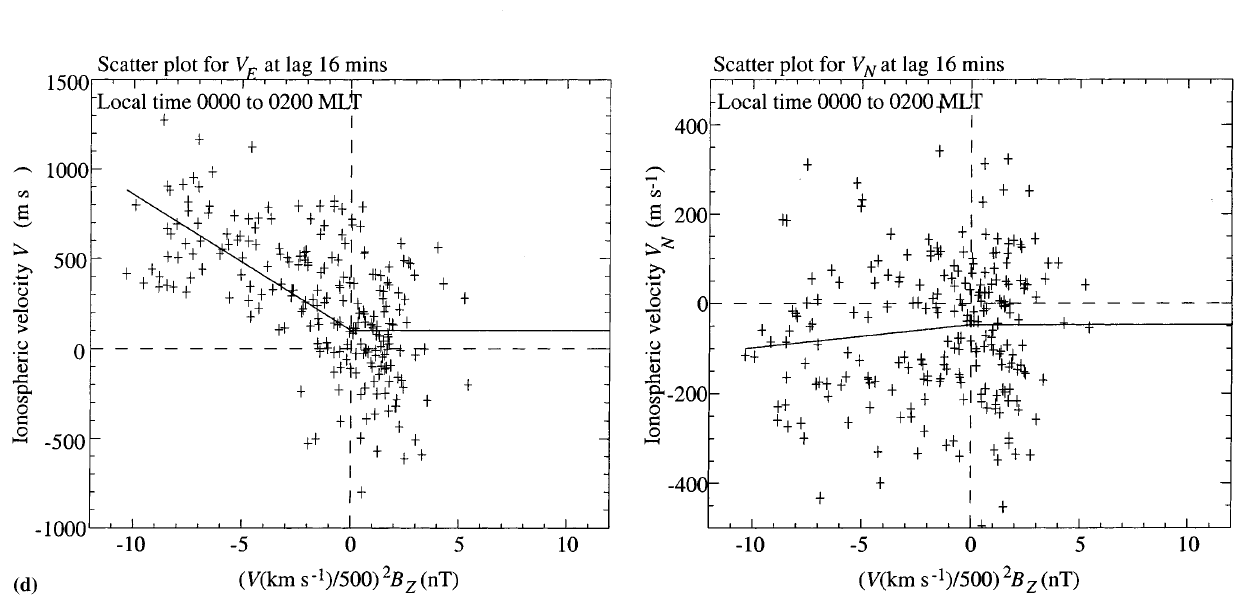
Fig. 4. d As for a except for the 2-h interval centred on